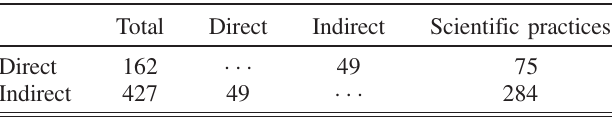
TABLE III. Number of times direct authenticity and indirect authenticity were co-coded with each other and with scientific practices